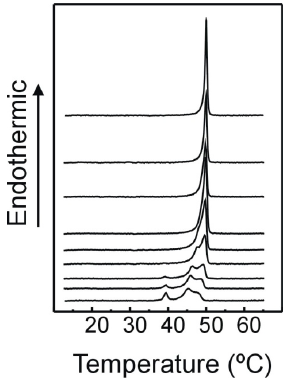
Figure 2. DSC thermograms depicting the effect of TMCG on the gel/liquid-crystalline phase transition of DMPE. Molar fraction of TMCG from top to bottom: 0, 0.02, 0.05, 0.07, 0.10, 0.15, 0.20, 0.25, and 0.30.